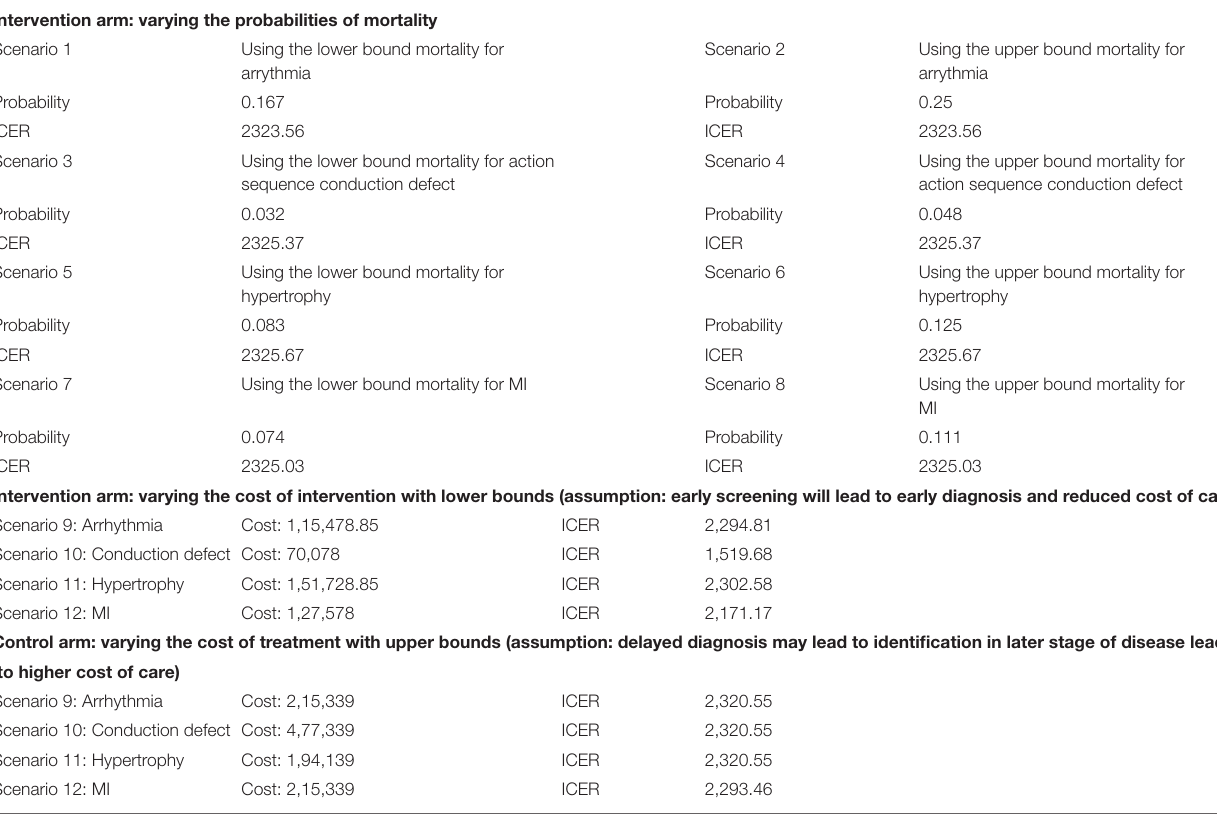
TABLE 4 | One-way sensitivity analysis. Intervention arm: varying the probabilities of mortality Scenario